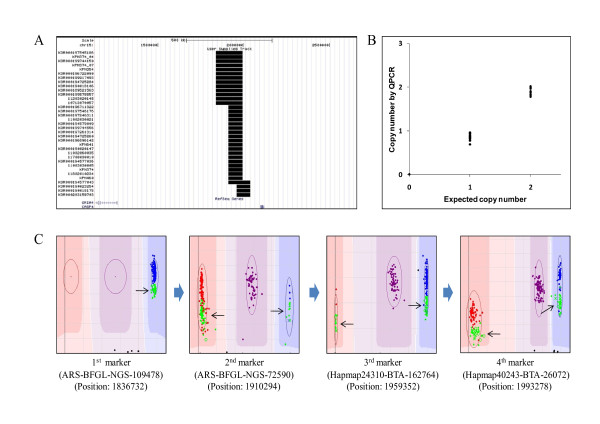
Visualization and validation of copy number variation region (chr15:1836732-2039483) by visual examination and quantitative PCR. (A) Visualization of identified individual copy number variations in UCSC Genome Browser. The black bars indicate copy number variation of each sample. (B) Determination of copy number by quantitative PCR around third marker (Hapmap24310-BTA-162764). (C) Visual examination by consecutive genoplot images of markers. The first marker shows a monomorphic pattern having 2× (color: blue), 1× (color: cyan), and 0× (color: black). The samples having a deletion (copy number: 1×; color:cyan) were consecutively displayed in deletion position to the fourth marker.